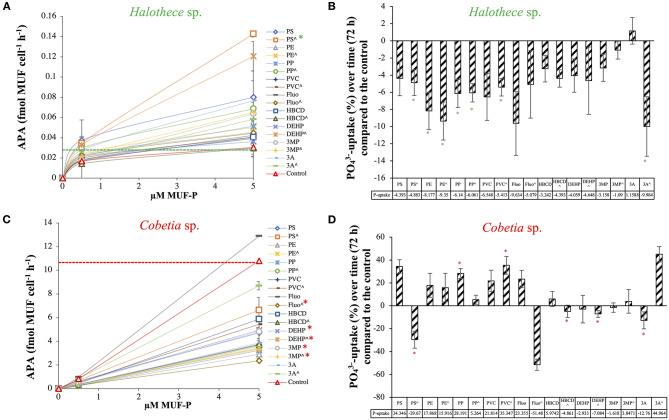
Phosphorus acquisition mechanisms for two species of N2-fixers exposed to different MPs and their plastic additives: (A) Alkaline phosphatase activity (APA, fmol MUF cell−1 h−1) and (B)
PO43--uptake (pmol PO43- cell−1 d−1) for Halothece sp., using relative values (with the control as reference). (C) APA and (D)
PO43--uptake for Cobetia sp., using relative values (with the control as reference). (∧) indicates treatments up to 1,000 μg mL−1 (MPs) and 3,000 μg L−1 (organic additives), without (∧) indicates treatments with 100 μg mL−1 (MPs) and 300 μg L−1 (organic additives). Values are the mean, and the error bar is the standard error between the replicates (n = 3). Asterisks (*) indicate significant differences (p < 0.05) compared with the controls, using a post-hoc test (Wilcoxon) after Kruskal-Wallis over the whole dataset.